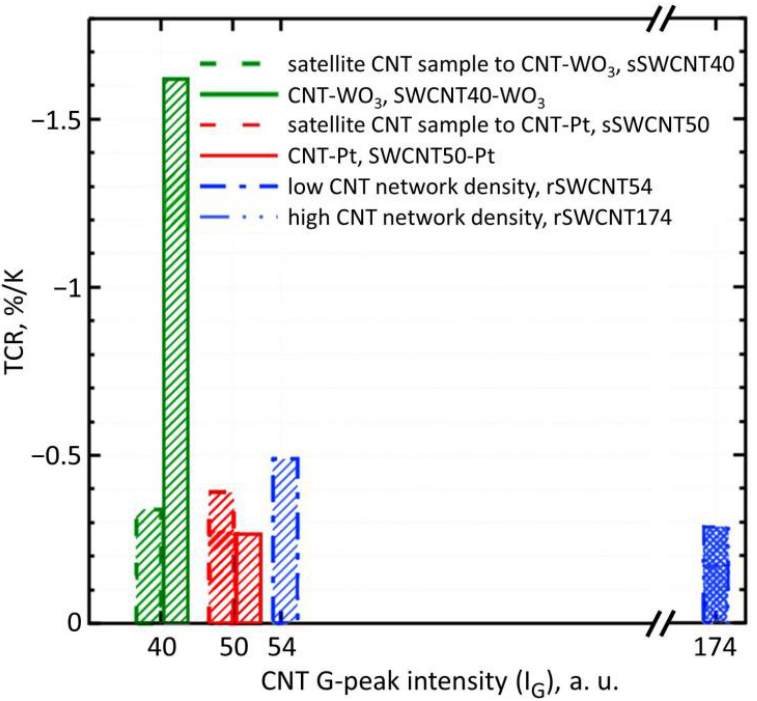
Figure 5. Temperature coefficient of resistance (TCR) for all the SWCNT-based sensor structures under study.